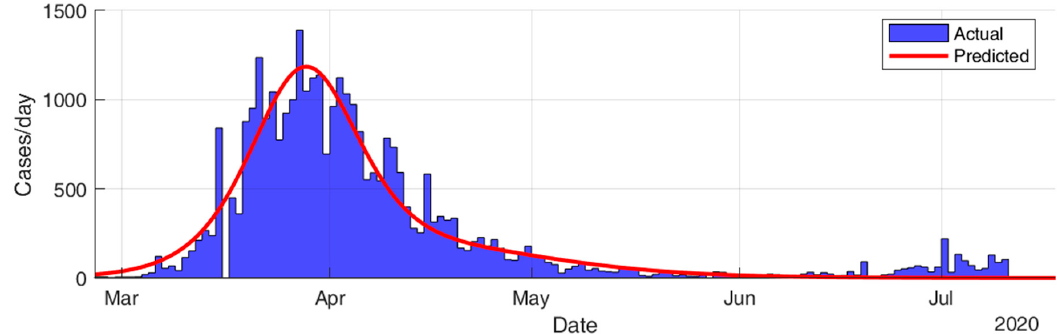
Figure 16. Prediction results for infection cases in Switzerland.